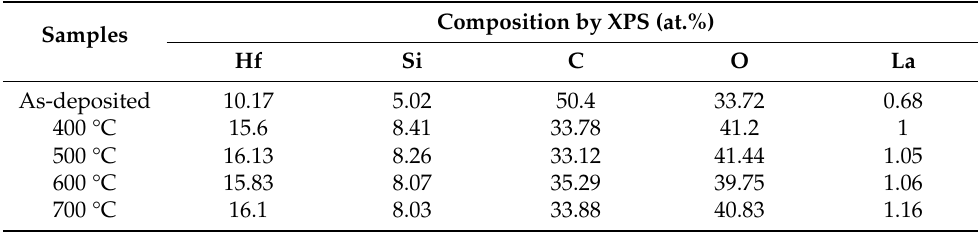
Table 1. XPS analysis of the composition for lanthanum-doped HfO 2 films as a function of anneal- ing temperature.